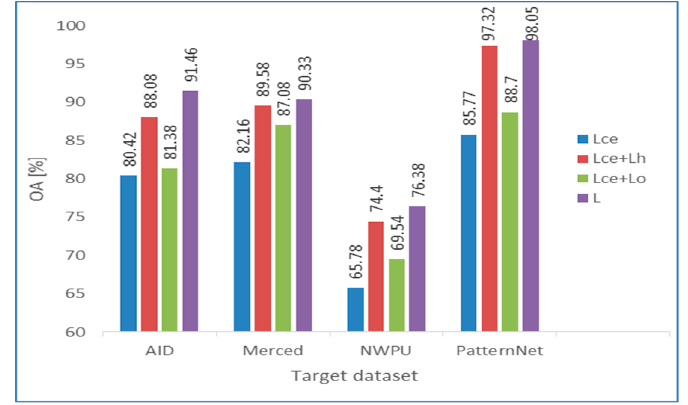
Figure 13. Sensitivity analysis with respect to the losses L ce , L h and L o . Table 3. Comparisons with respect to state-of-the-art methods.